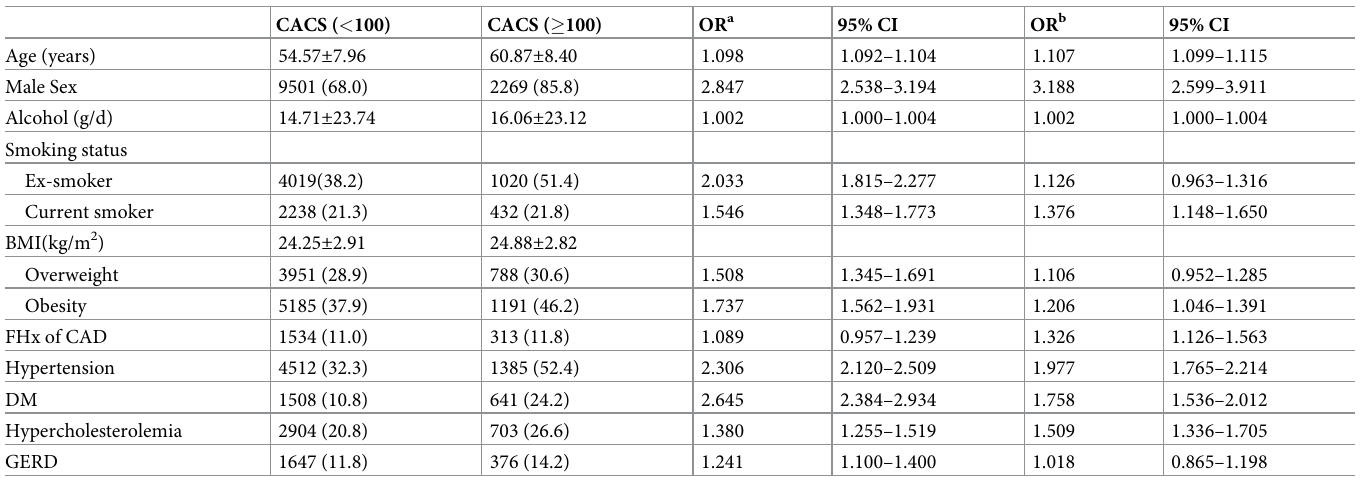
Table 2. Risk factors for high CACS ( �